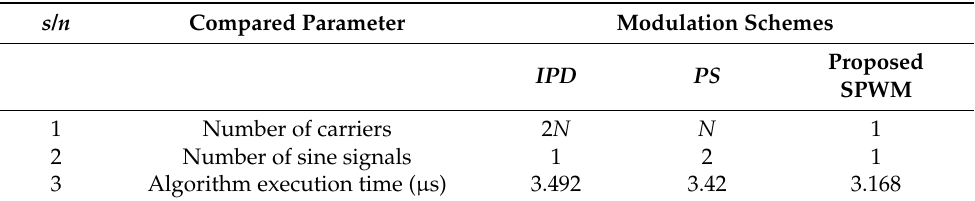
Table 2. Comparison of conventional and proposed SPWM schemes.